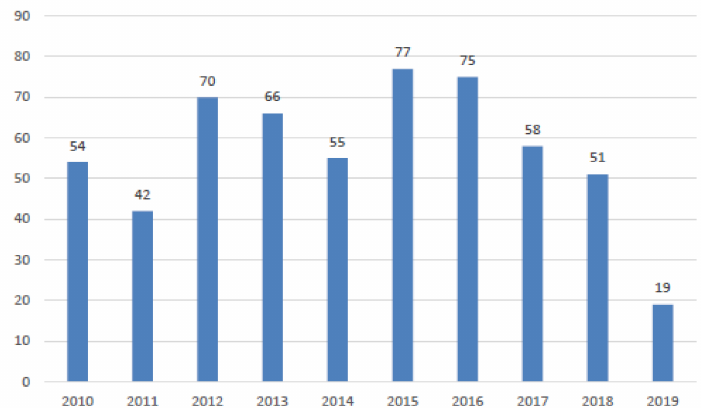
Figure 1. New claims per year (2019 represents data for the first six months).